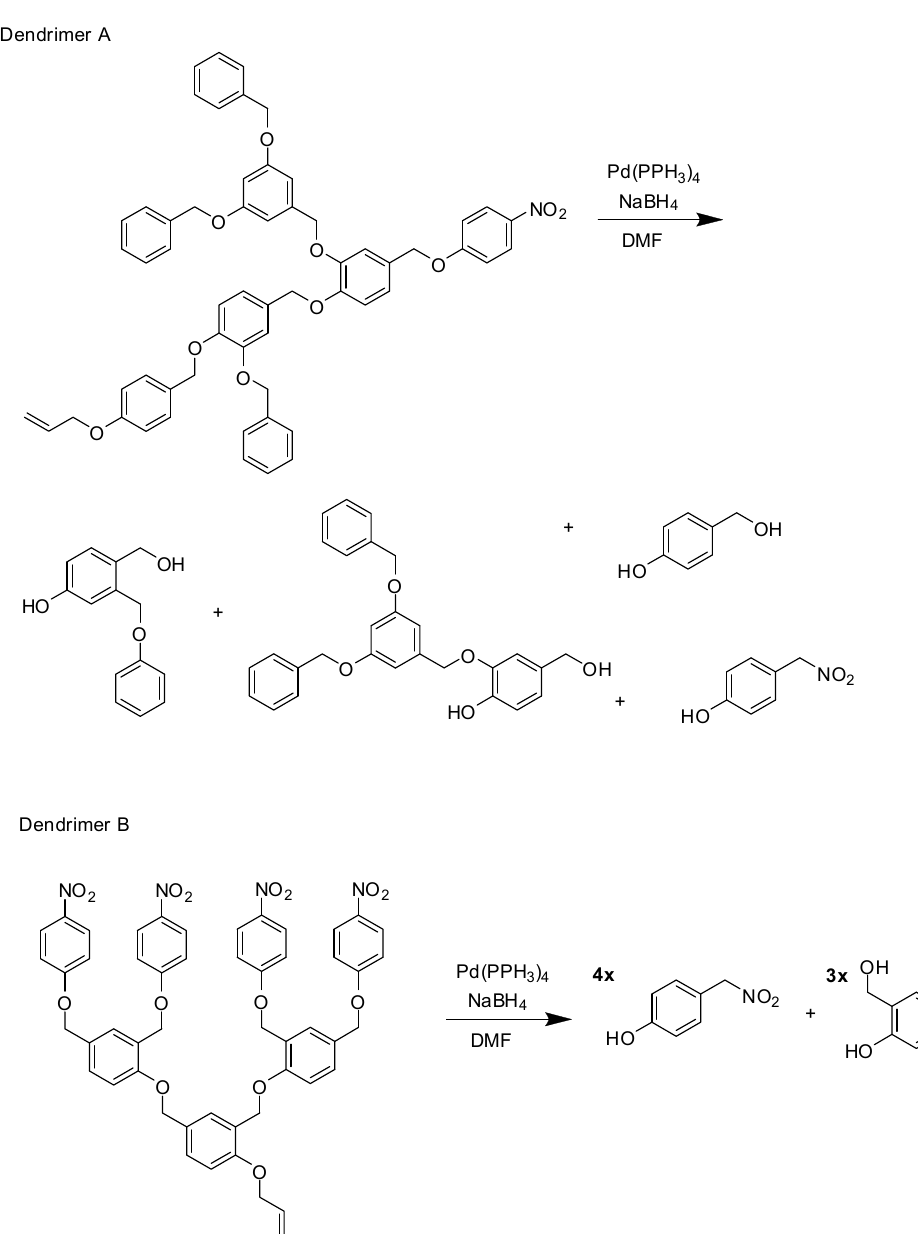
Figure 8. Chemical disassembly of second generation dendrimers [52].